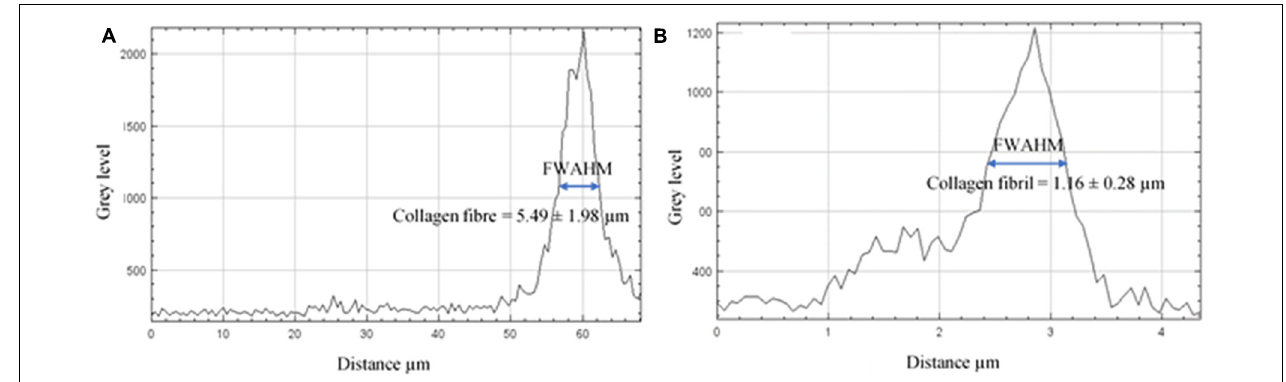
FIGURE 8 | The gray level intensity distribution graphs across the collagen fibers and fibrils. (A) The FWAHM and gray level intensity distribution graph across the thickness of the collagen fibers were used to measure the thickness of the collagen fibers comprising the pars tensa. (B) The FWAHM and gray level intensity distribution graph across the thickness of the collagen fibrils were used to measure the thickness of the collagen fibrils.